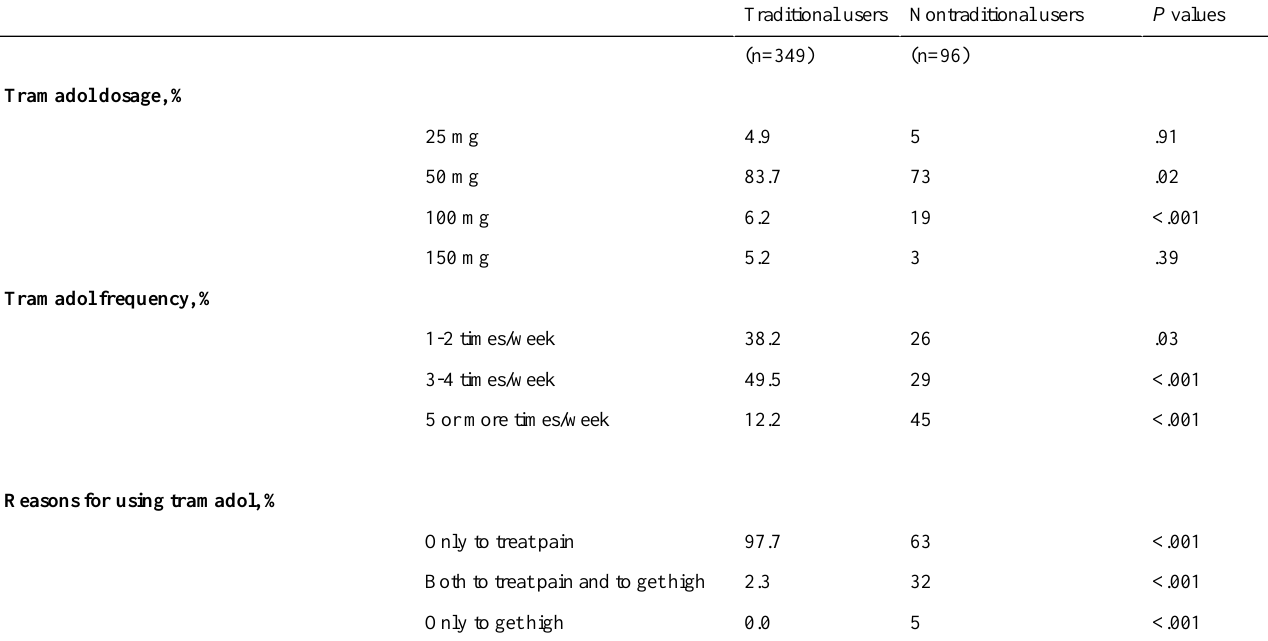
Table 2. Tramadol use among traditional and nontraditional